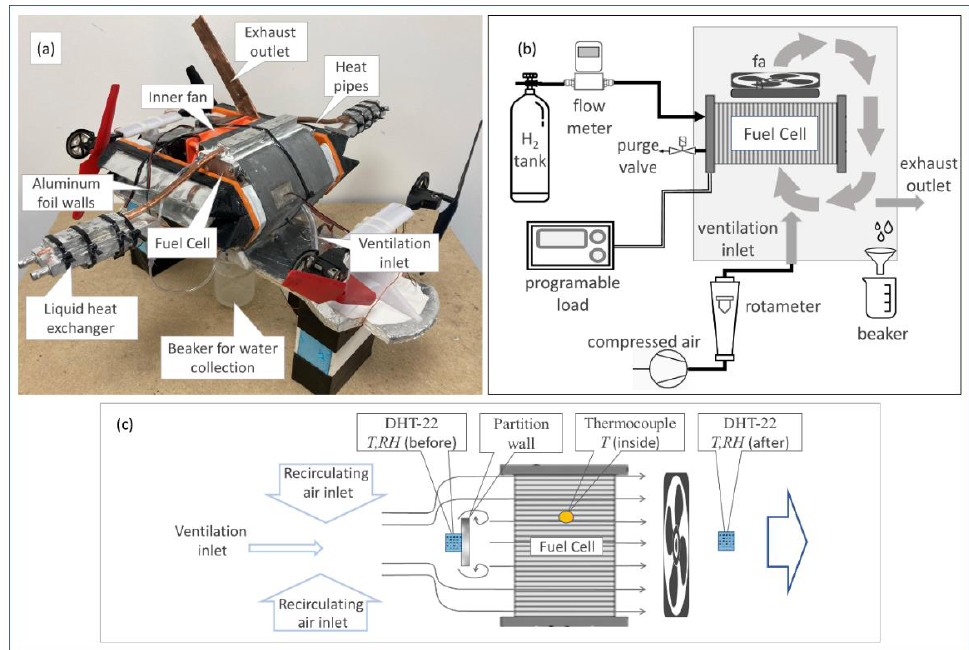
Figure 5. The experimental setup: a representing photo ( a ) and a schematic description ( b ), including the fuel cell enclosed inside a circulating dome with a fan, a ventilation inlet and exhaust outlet, Hydrogen supply, programmable load, flowmeters, and the collecting beaker. Temperature and humidity sensors were placed before and after the FC and a thermocouple was mounted inside the FC ( c ).